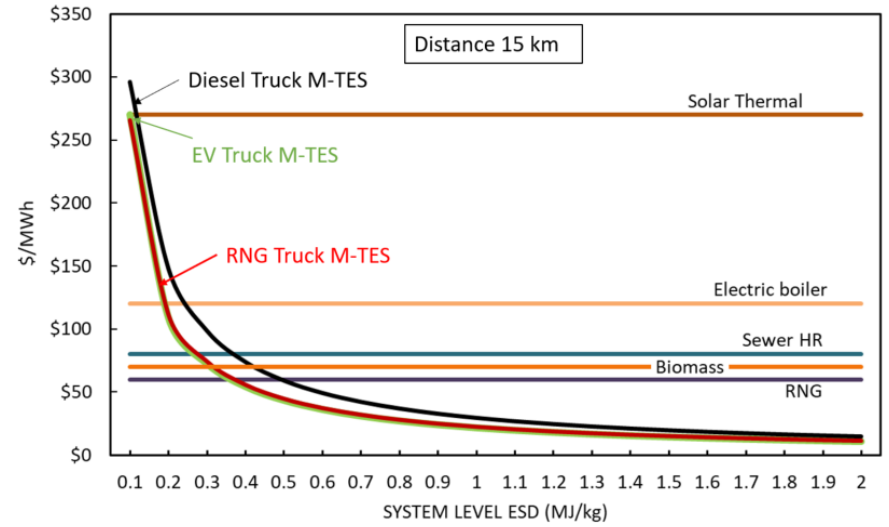
Figure 4. M-TES $/MWh with different ESD and transportation modes with a 15 km distance between the industrial waste heat and district energy network.